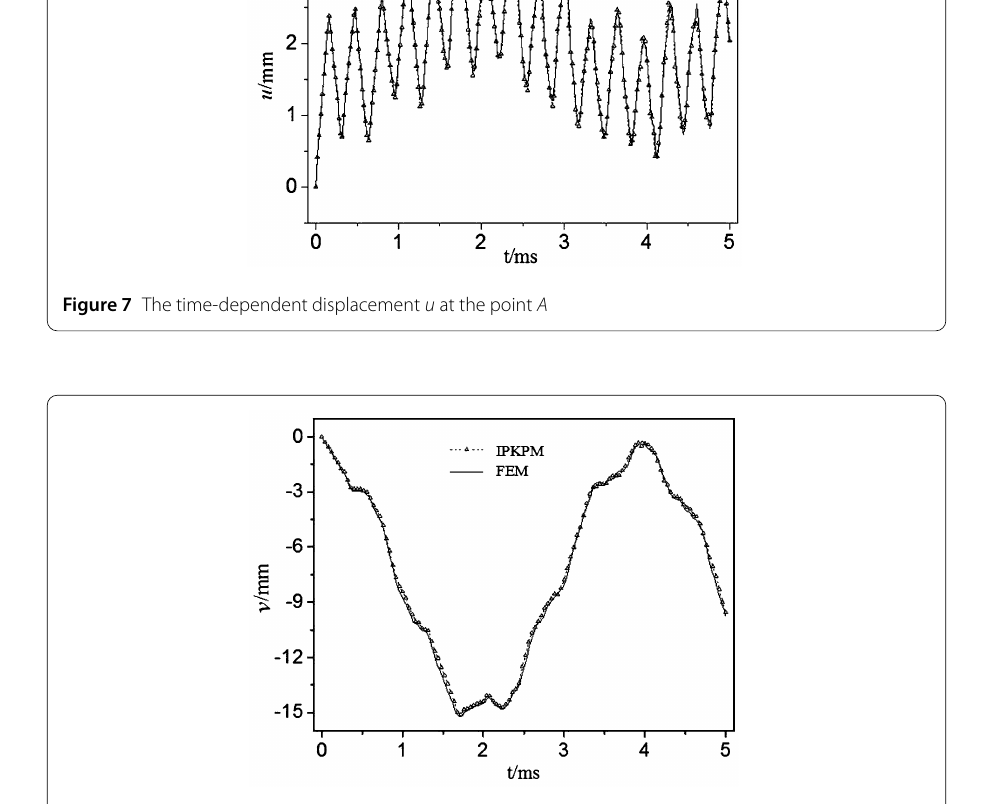
Figure 8 The time-dependent displacement v at the point A